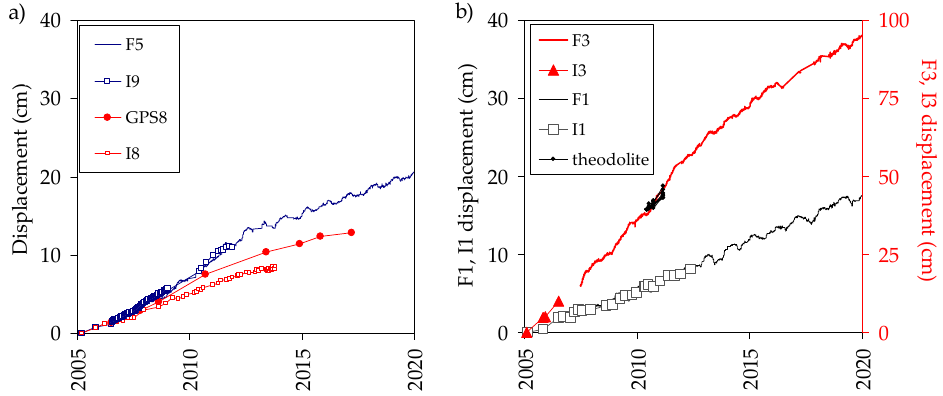
Figure 9. Comparison of: inclinometer and GPS data of Costa della Gaveta earthflow ( a ); inclinometer, GPS, and theodolite data of Varco d’Izzo earthflow ( b ).